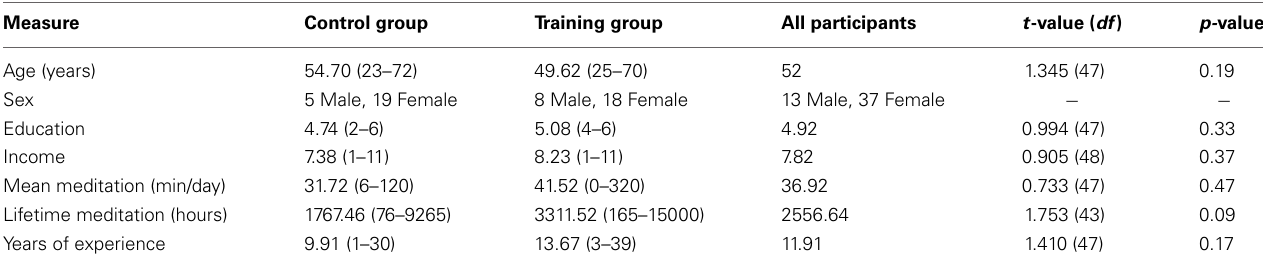
Table 1 | Group matching on demographic and experience